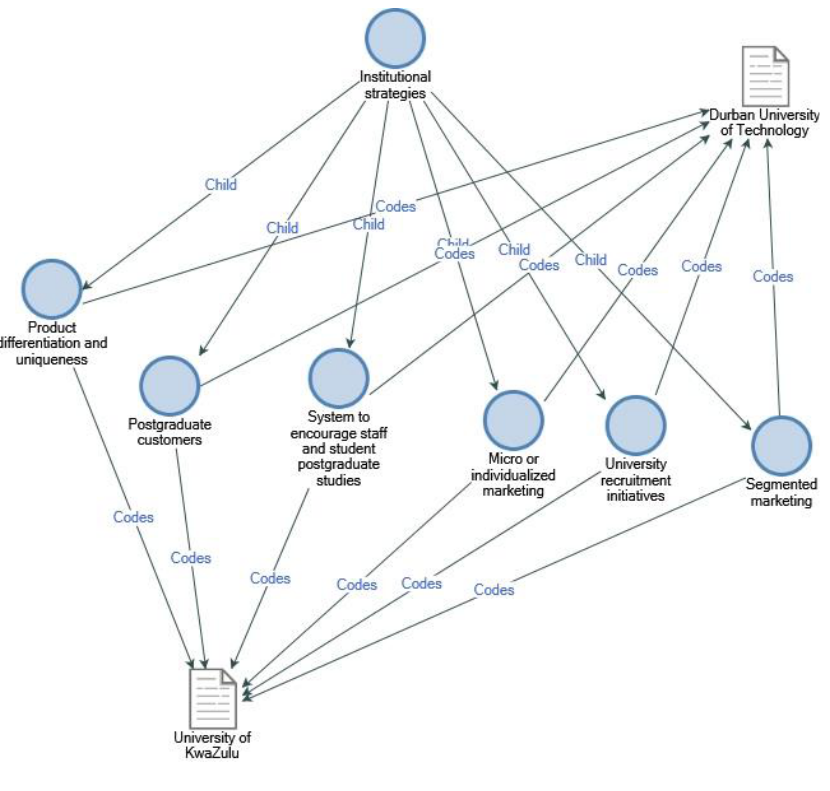
Figure 2: virtualization of institutional